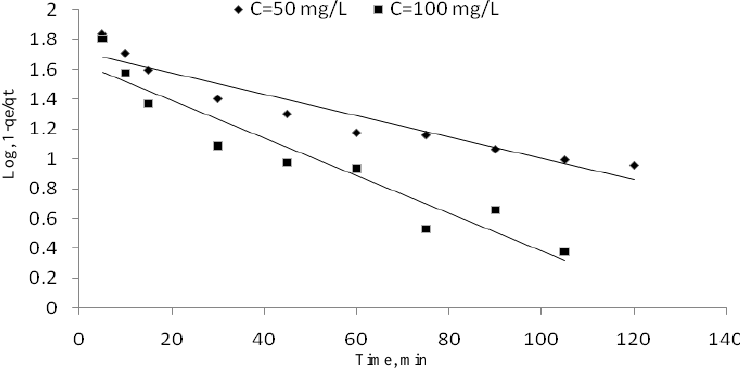
Figure 11. Pseudo-first order kinetic model; Time 120 min, dose: 0.04 g/100 ml, pH 7.